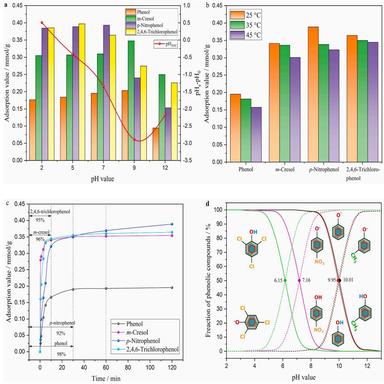
Effect of initial solution pH (a), temperature (b) and time (c) on the adsorption of phenolic compounds onto MCM and the ionization equilibrium of phenolic compounds as function of solution pH (d).